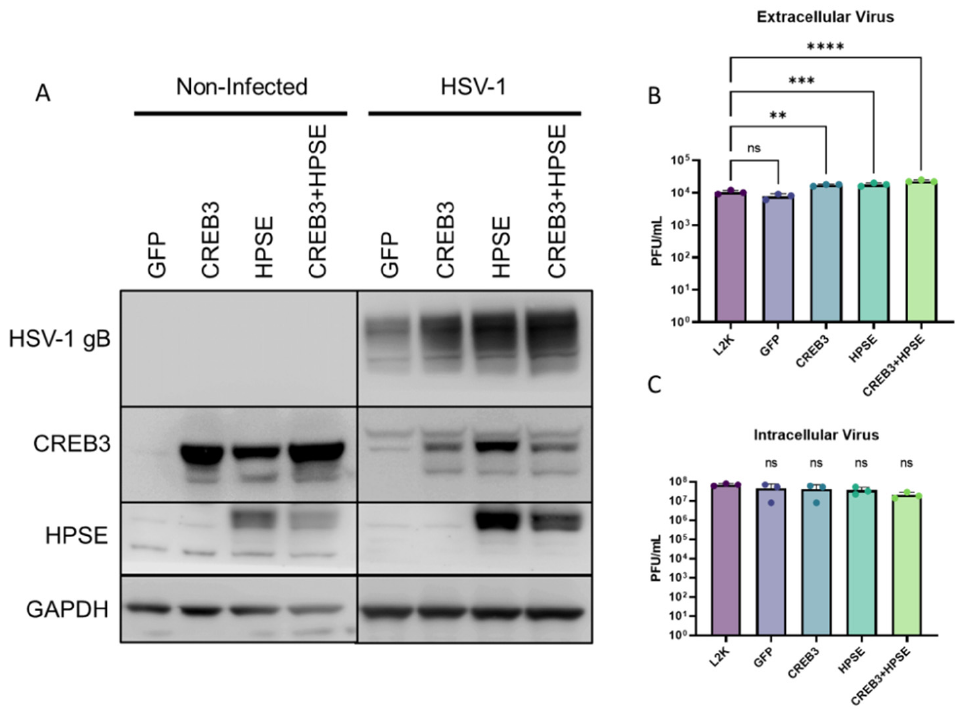
Figure 5. Co-expression of CREB3 and HPSE increased extracellular virus release: ( A ) Human corneal epithelial cells were left non-transfected, treated with lipofectamine alone, or transfected with a control plasmid, CREB3 plasmid, or full-length HPSE plasmid for 24 h followed by infection with HSV-1 for 24 h. ( A ) Cell lysates were immunoblotted to confirm co-transfection of CREB3 and HPSE. ( B ) Cellular supernatants were collected, centrifuged, and overlayed on Vero cells to titrate infectious titer present in the extracellular space via a plaque assay. ( C ) Cell lysates were collected, ultrasonicated, and overlaid on Vero cells to titrate intracellular infectious titer via a plaque assay. One-way ANOVA was performed between the sample sets to determine statistically significant differences. ns-non-significant ** p -value < 0.01, *** p < 0.001, **** p < 0.0001.